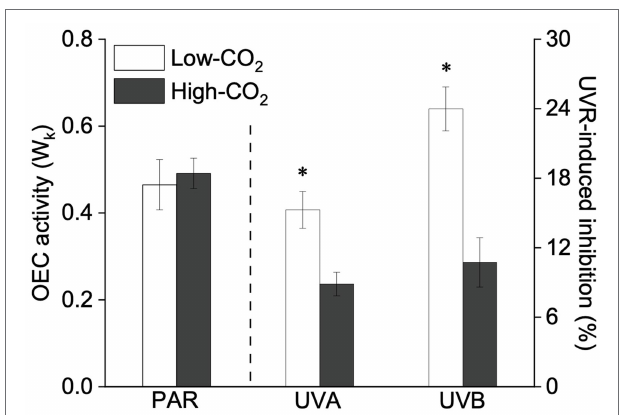
FIGURE 1 | Values (a.u., left pair of bars) and UVR-induced inhibition (%, right two pairs of bars) on the O 2 -evolving complex (OEC) activity (the normalized variable fluorescence at the K-step relative to the amplitude of F J − F o , W k ) of Pyropia yezoensis growing for 9 days at low (~400 μ atm, open bars) and high (~1000 μ atm, closed bars) CO 2 conditions. Data are means ± SD ( n = 3). The symbol “ * ” indicates a significant ( p < 0.05, t -tests) difference between the treatments in each pair.